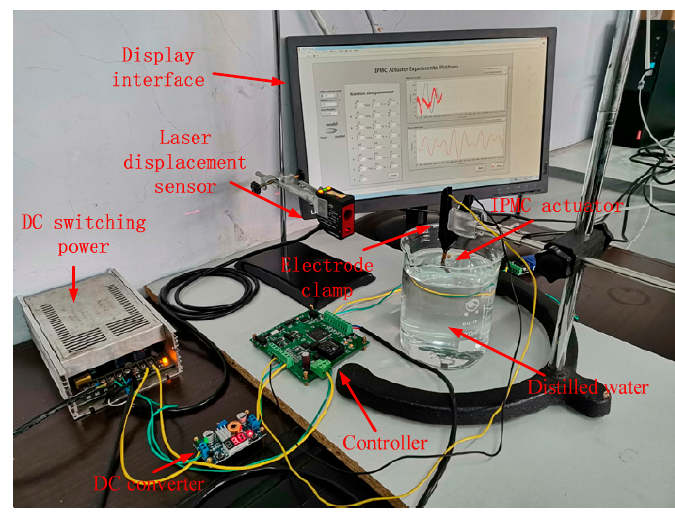
Figure 1. Customized platform for IPMC actuators.